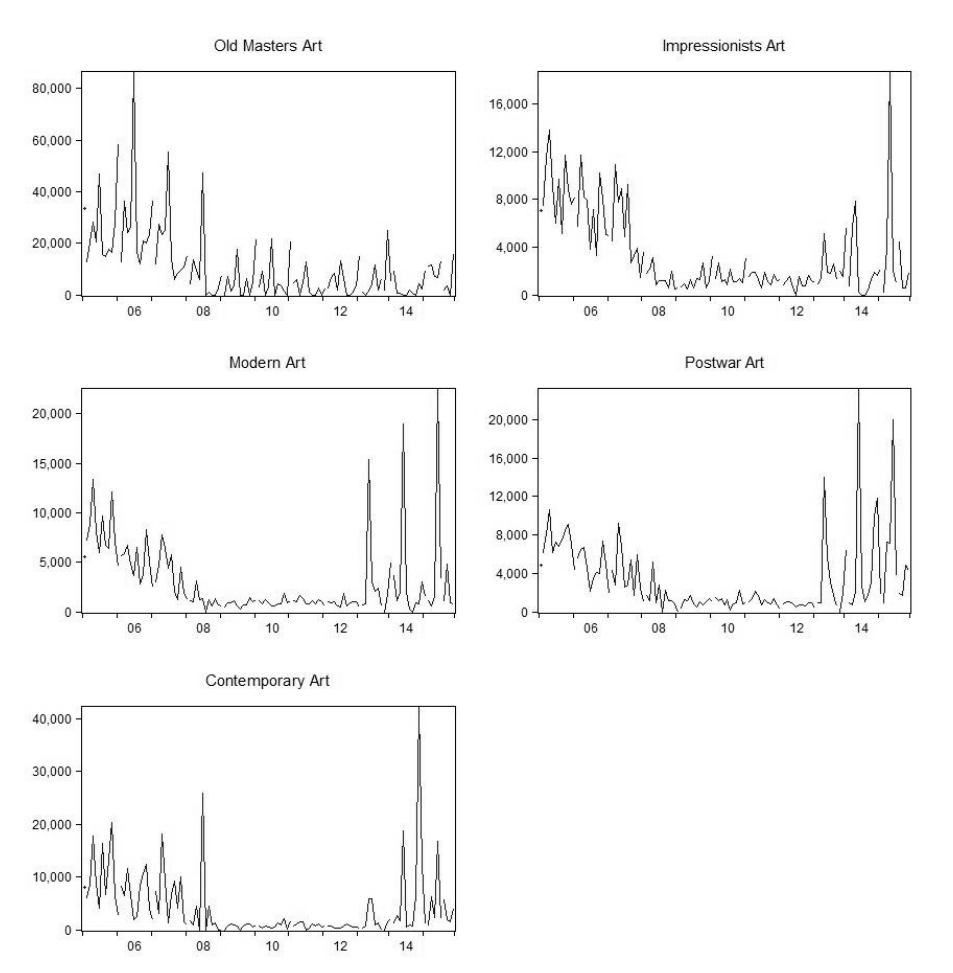
Figure A1. Dynamics of prices by